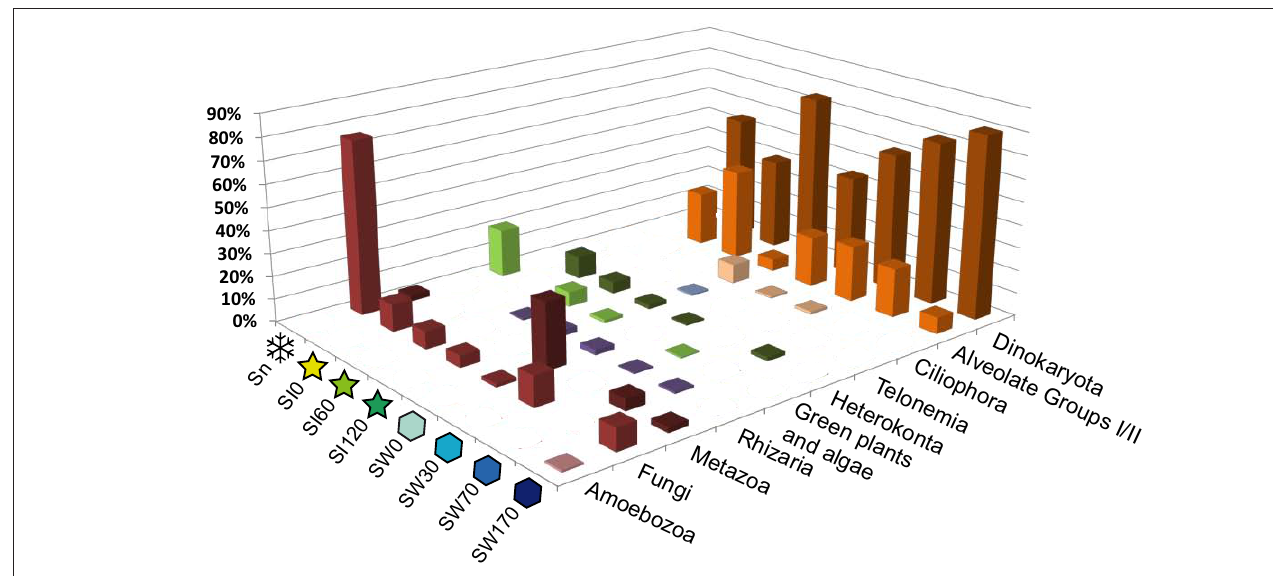
Figure 2 | relative 18S rDNA abundance of major eukaryotic groups in gene libraries from samples near the North Pole. For sample names, see Figure